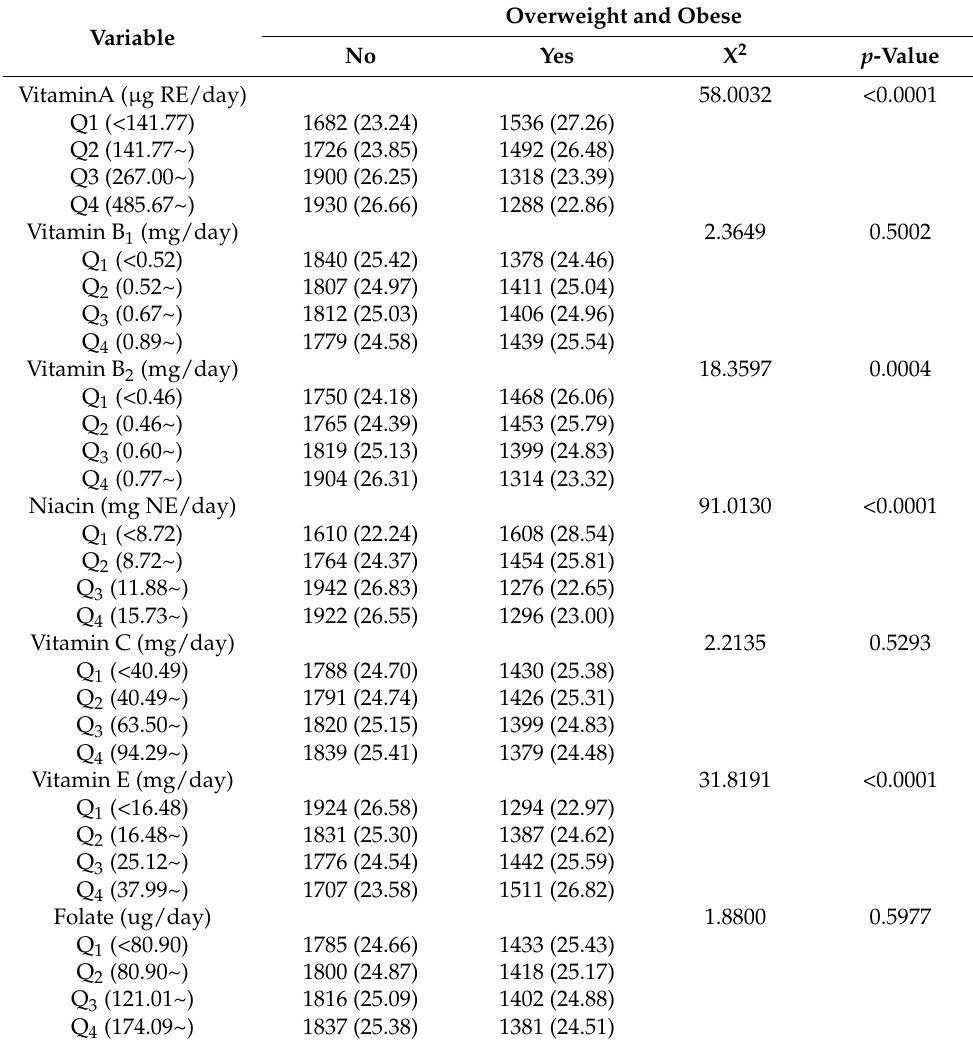
Table 3. Univariate analysis of the effect of dietary vitamin intake on overweight/obesity in non- pregnant and non-lactating women aged 18–49 years.